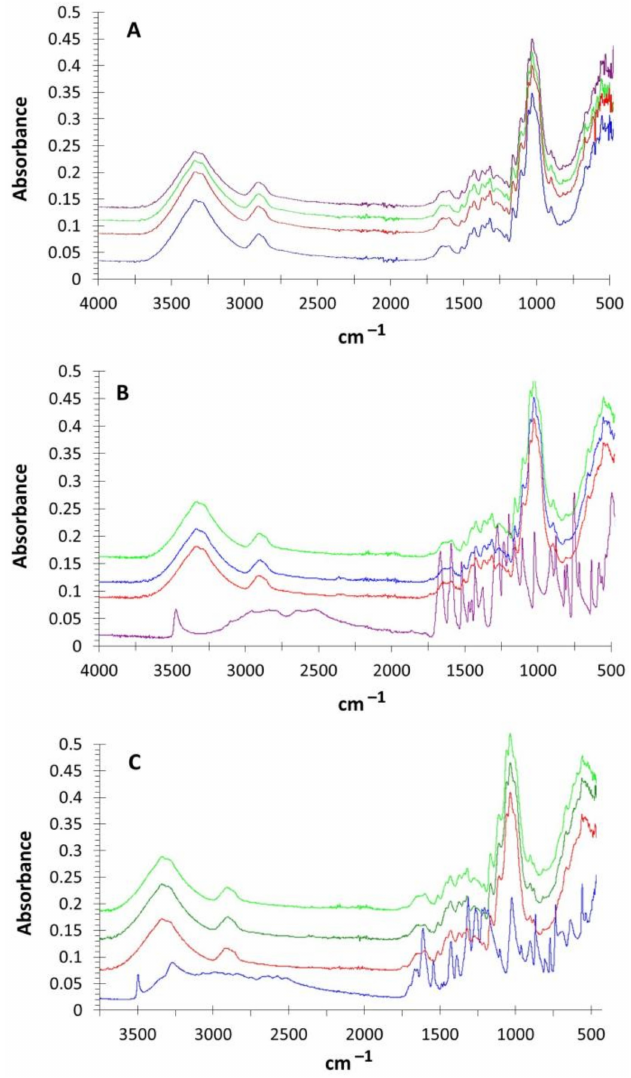
Figure 3. ( A ) Infrared spectra for blank (purple), catechol mediator (green), paper treated with laccase, 1,2–DHB and CMC (Carboxymethyl cellulose) (red); ( B ) infrared spectra for blank (green), vanillic acid mediator (purple) and sample of VA (Vanillic acid) and CPX by duplicate in blue and red; ( C ) infrared spectra for blank (green), gallic acid mediator (blue) and sample of GA by duplicate in dark green and